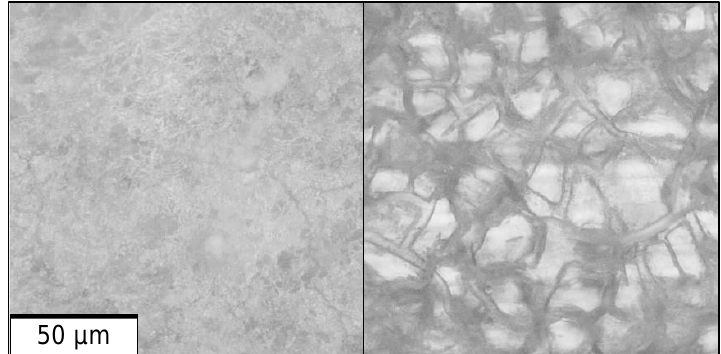
Figure 6. Optical microscopic images of the sample surface after polarization at constant potential (OCP + 4 V) in electrolytes 2 ( left ) and 4 ( right ). The scale bar applies to both images.